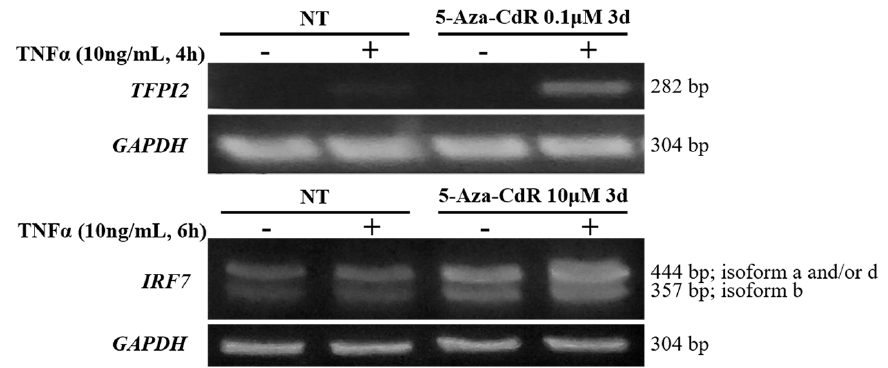
Figure 5. Demethylation restored the function of -1C κ B sites. U937 and HEK 293T cells that do not express TFPI2 or IRF7, respectively, were treated with or without 5-Aza-CdR for three days. TFPI2 or IRF7 expression upon TNF α stimulation was then analyzed by reverse transcription PCR (RT-PCR). GAPDH expression was used as internal controls. Data shown are the results of one of three experiments.